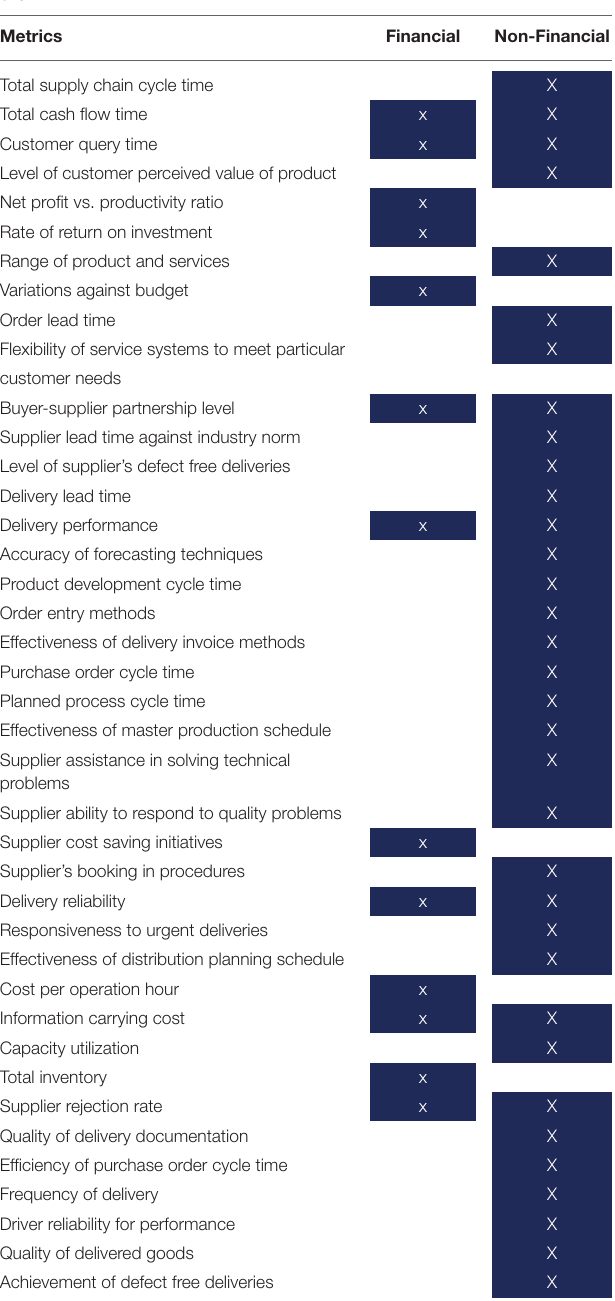
TABLE 3 | A framework on metrics for assessing the performance of a supply